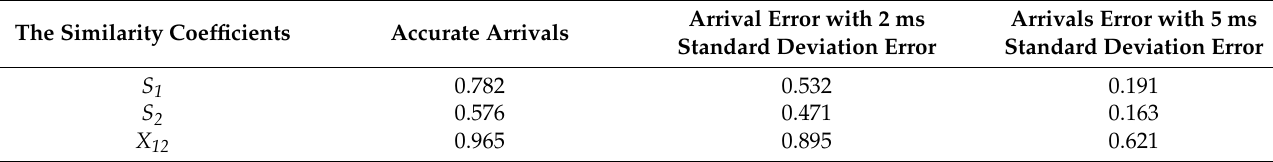
Figure 1. Two synthetic microseismic signals and the recordings after moveout correction using arrivals with different error levels. ( a , e ) are the synthetic recordings; ( b , f ) are the recordings after moveout correction using accurate arrivals; ( c , g ) are the recordings after moveout correction using arrivals with 2 ms standard deviation error; ( d , h ) are the recordings after moveout correction using arrivals with 5 ms standard deviation error. The blue traces are the stacked waveforms. Table 1. Quality Assessment for the arrivals with various error